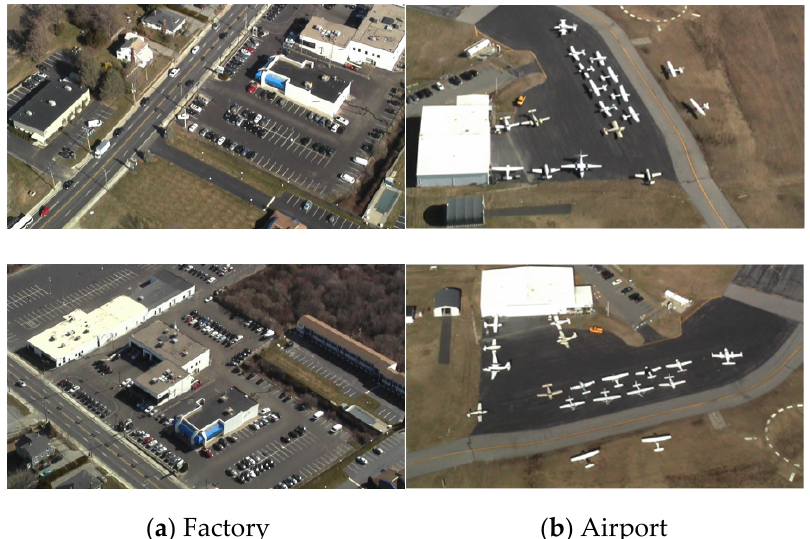
Figure 2. Image deformation caused by changes in the external orientation elements.